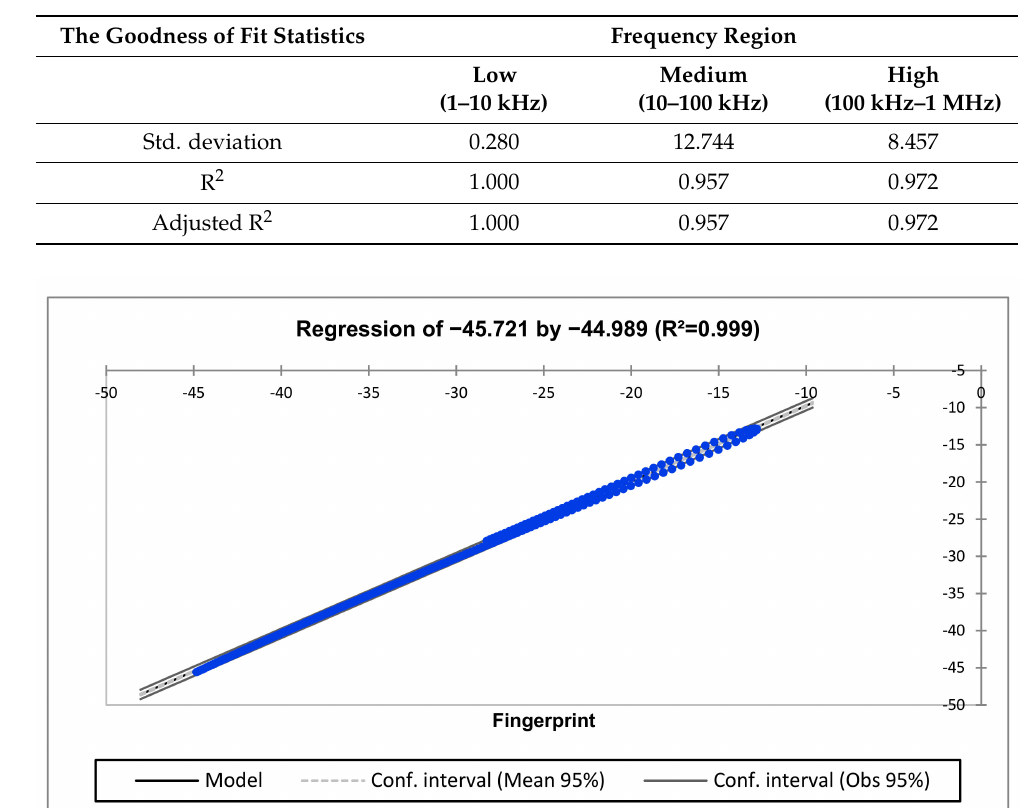
Table 15. Regression analysis for H3-H2 vs. H1-H3.